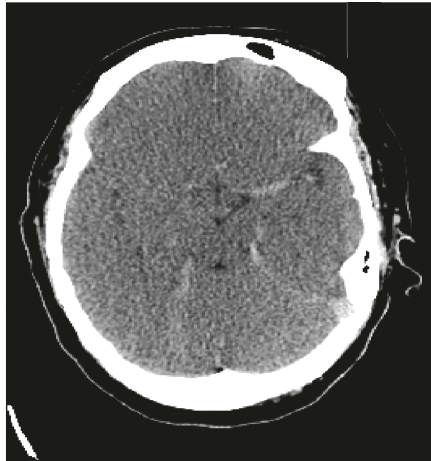
Figure 3: Noncontrast head computed tomography (CT) showing diffuse cerebral edema, with hyperattenuated cisterns and cerebral